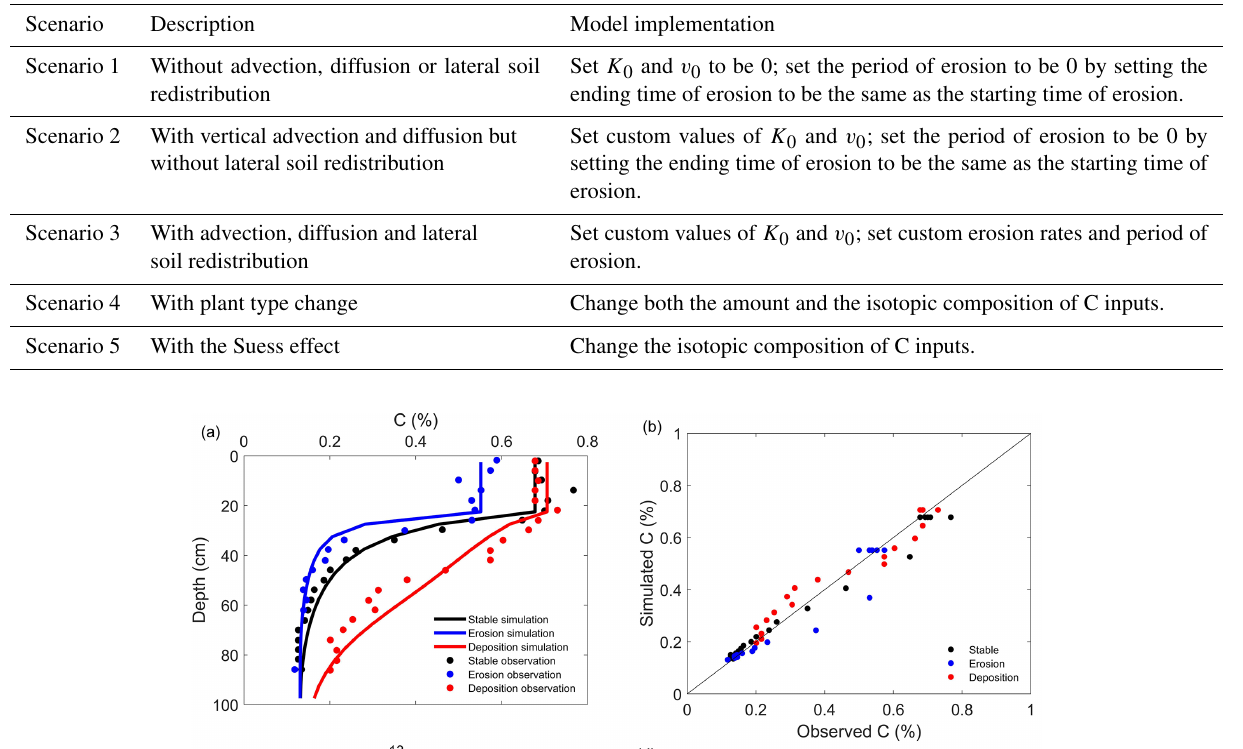
Table 2. Model scenarios implemented in this study.